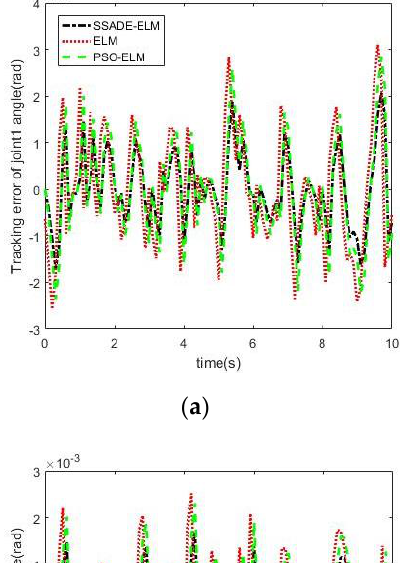
( f ) Figure 7. Space robot attitude parameters by simulation. ( a ) The base angle; ( b ) The base angular velocity; ( c ) The joints angle via Variable Forgetting Factor Recursive Least Squares (VFF–RLS); ( d ) The joints angle via RLS; ( e ) The joints angular velocity via VFF–RLS; ( f ) The joints angular velocity via RLS.